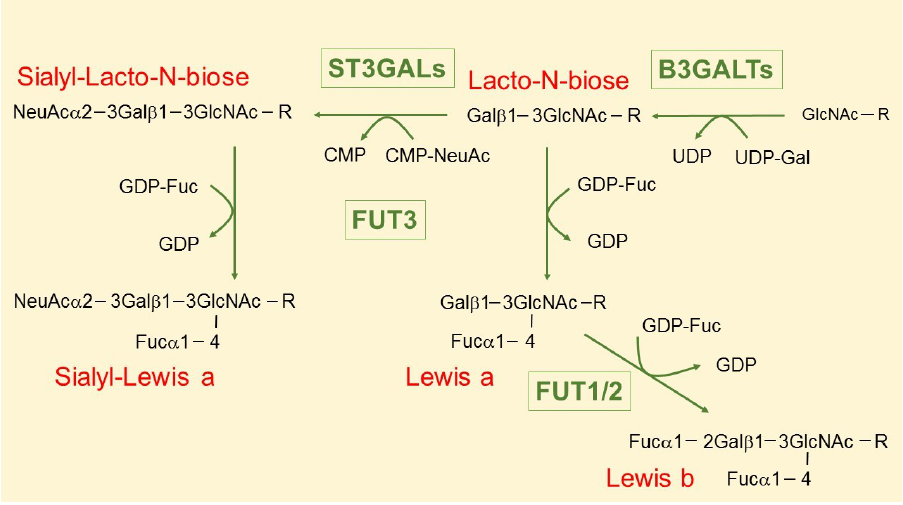
Figure 1. Biosynthesis of type 1 chain Lewis antigens. B3GALTs include B3GALT5, B3GALT1 and B3GALT2; ST3GALs are α2,3 sialyltransferases acting on galactose and include ST3GAL3 and possibly ST3GAL4; FUT3 is a unique α1,4 fucosyltransferase acting on N-acetylglucosamine; FUT1 and FUT2 are α1,2 fucosyltransferases acting on